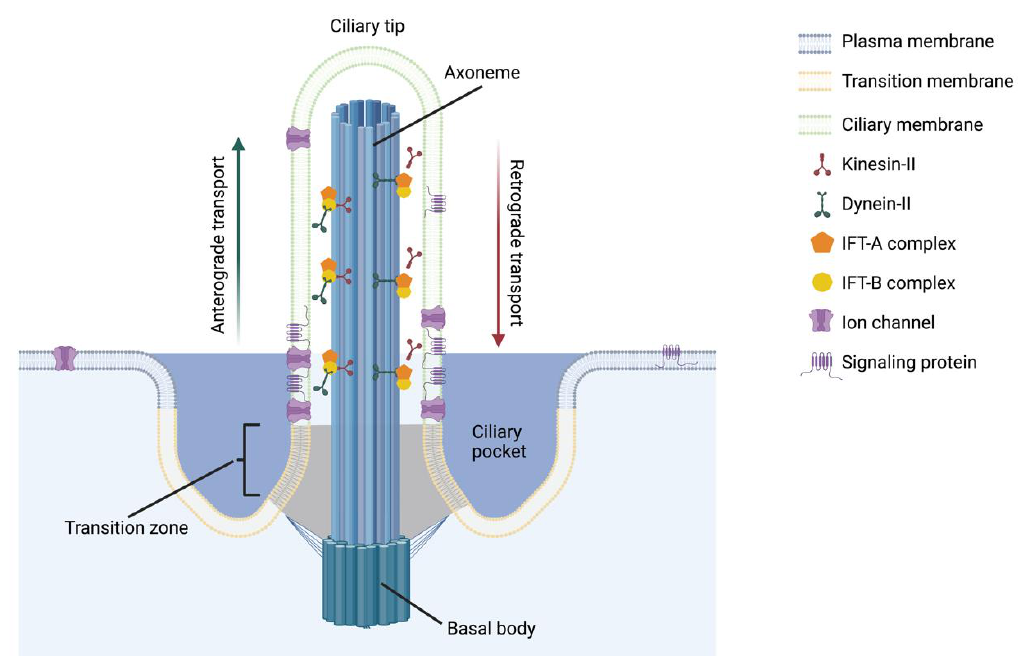
Figure 1. Primary cilium structure and intraflagellar transport (IFT) components. The primary cilium is composed of an anchoring basal body and an axoneme that extends from the cell surface. The axoneme is encapsulated by a ciliary membrane that is distinct from but continuous with the plasma membrane. Signaling proteins, such as ion channels and receptors, are especially concentrated near the axoneme base to facilitate signaling amplification. The axoneme structure is maintained by IFT and its components including kinesin-II, dynein-II, IFT-A, and IFT-B. This figure was created with BioRender.com (accessed on 10 November 2022) .